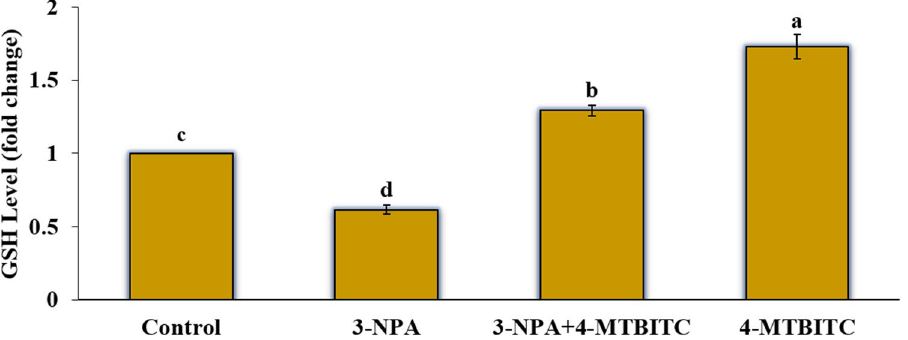
Figure 4. The effect of 4-MTBITC on SH-SY5Y cells treated with or without 3-NPA on the intracellular GSH level measured by using MCB fluorescent probe. Data (mean ± SEM; p ≤ 0.05) are expressed as fold change for three independent experiments (one-way ANOVA, followed by the Tukey post hoc